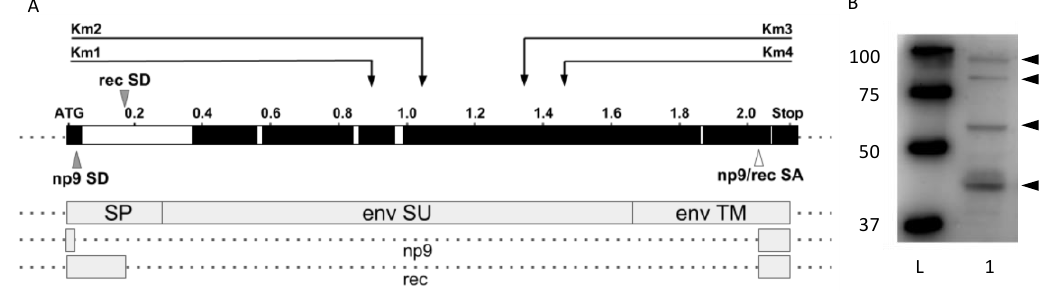
Figure 1. Schematic representation of the human endogenous retrovirus (HERV)-K env gene and of the spliced mRNAs, showing the targets for gRNAs, and the basal production of HERV-K Env proteins by the LNCaP cell line. ( A ) Map of the proviral HERV-K env gene, spanning from the ATG to the Stop codon. The singly spliced SU and TM env mRNA, the doubly spliced np9 and rec mRNAs are shown as white boxes. The arrows indicate the targets of the Km1, Km2, Km3, and Km4 gRNAs. The arrowheads indicate the donor (grey arrowhead) and acceptor (white arrowhead) splicing sites, leading to the HERV-K np9 and HERV-K rec mRNA splicing. ( B ) HERV-K Env proteins produced by LNCaP cells cultured for 48 h, as detected by Western blot assay. After blotting, the relevant bands were recognized by an anti-HERV-K Env mAb, as described in Methods. See Results for details. Lane 1: protein ladder (precision plus protein western C standards, Biorad, Hercules, California, USA), Lane 2: LNCaP cell lysate. Arrowheads: Env-specific bands. All the four HERV-K Env species are visible in this membrane.